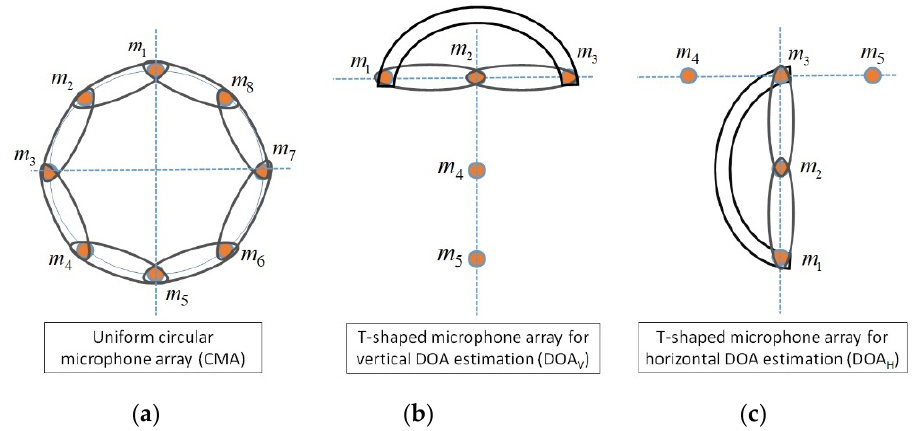
Figure 2. The proposed structure of T-shaped circular distributed microphone array for SSL, ( a ) central uniform circular array (in combination with GCC-PHAT/ML method), the T-shaped microphone array for ( b ) vertical DOA estimation (DOA V ) (in combination with GEVD method), and ( c ) horizontal DOA estimation (DOA H ) (in combination with GEVD method).